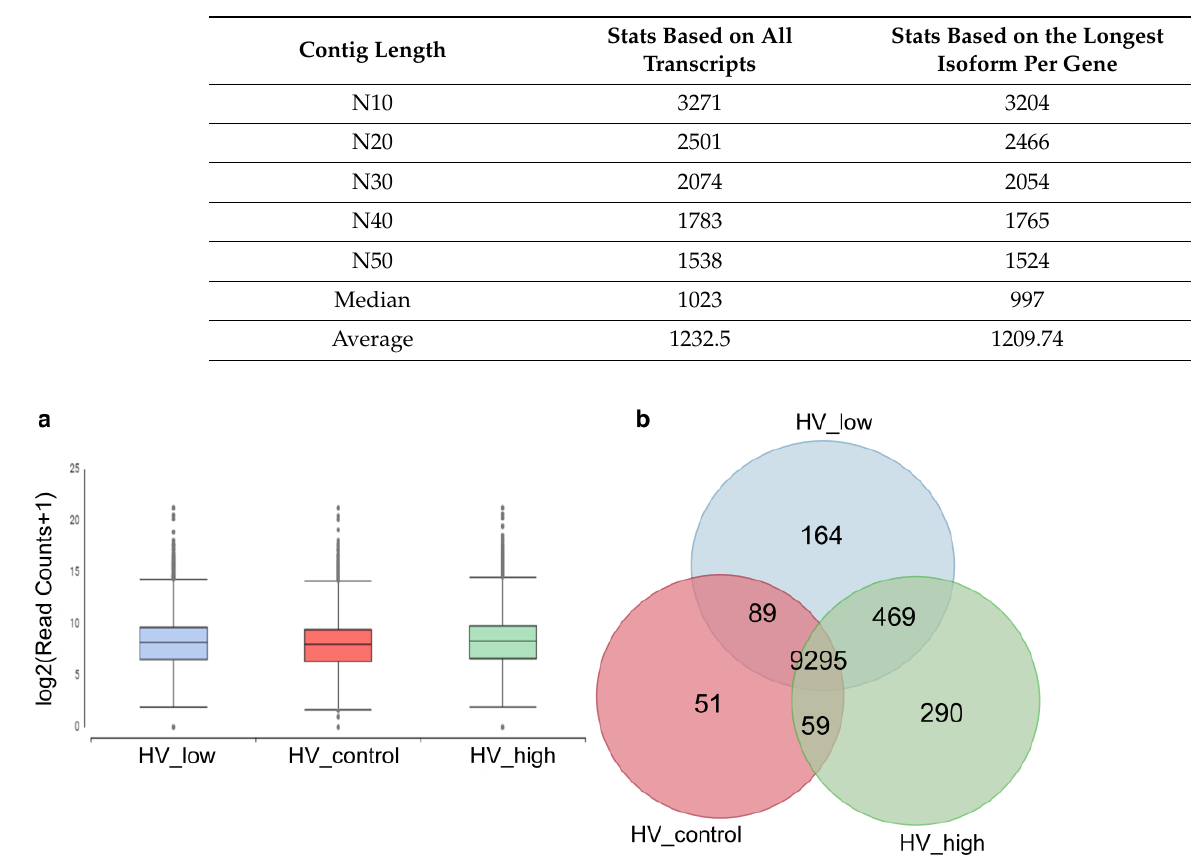
Table 1. Contig length distribution of reference transcripts assembled of combined read sets of control, high and low dosage treated samples in the phytotron.